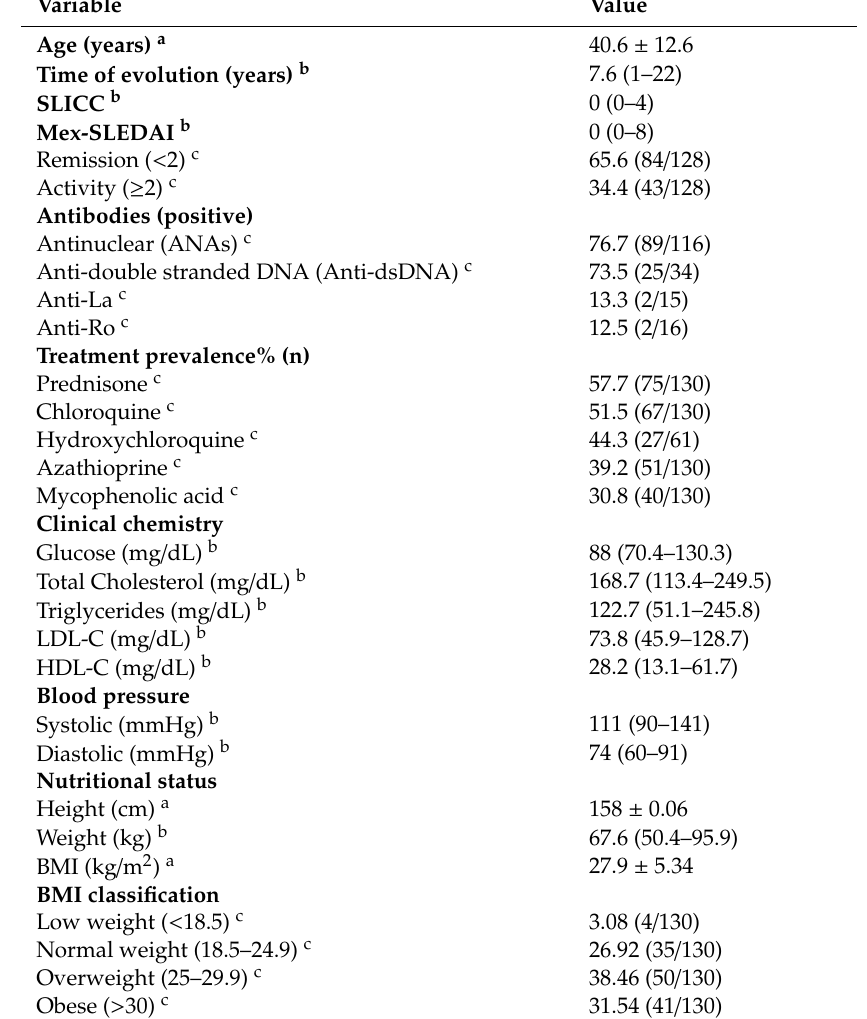
Table 1. Clinical characteristics and nutritional status from overall systemic lupus erythematosus